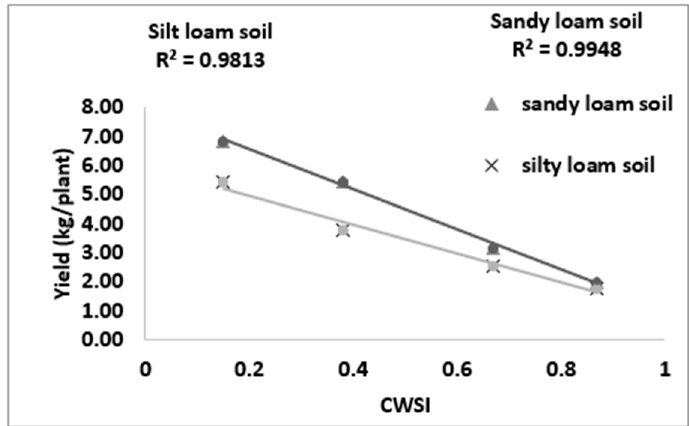
Figure 11. Relationship between the CWSI and